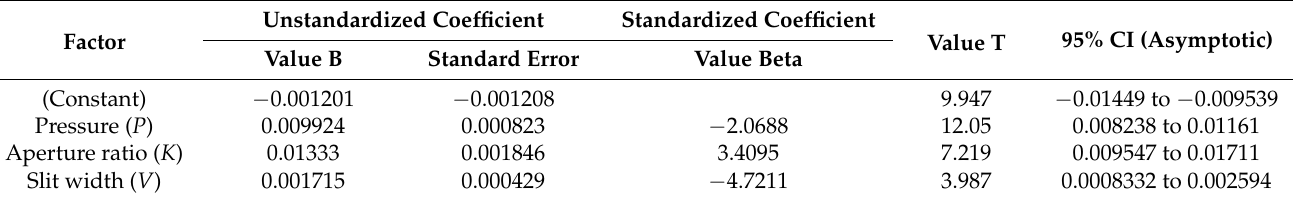
Table 4. Coefficient table of fitted equations.